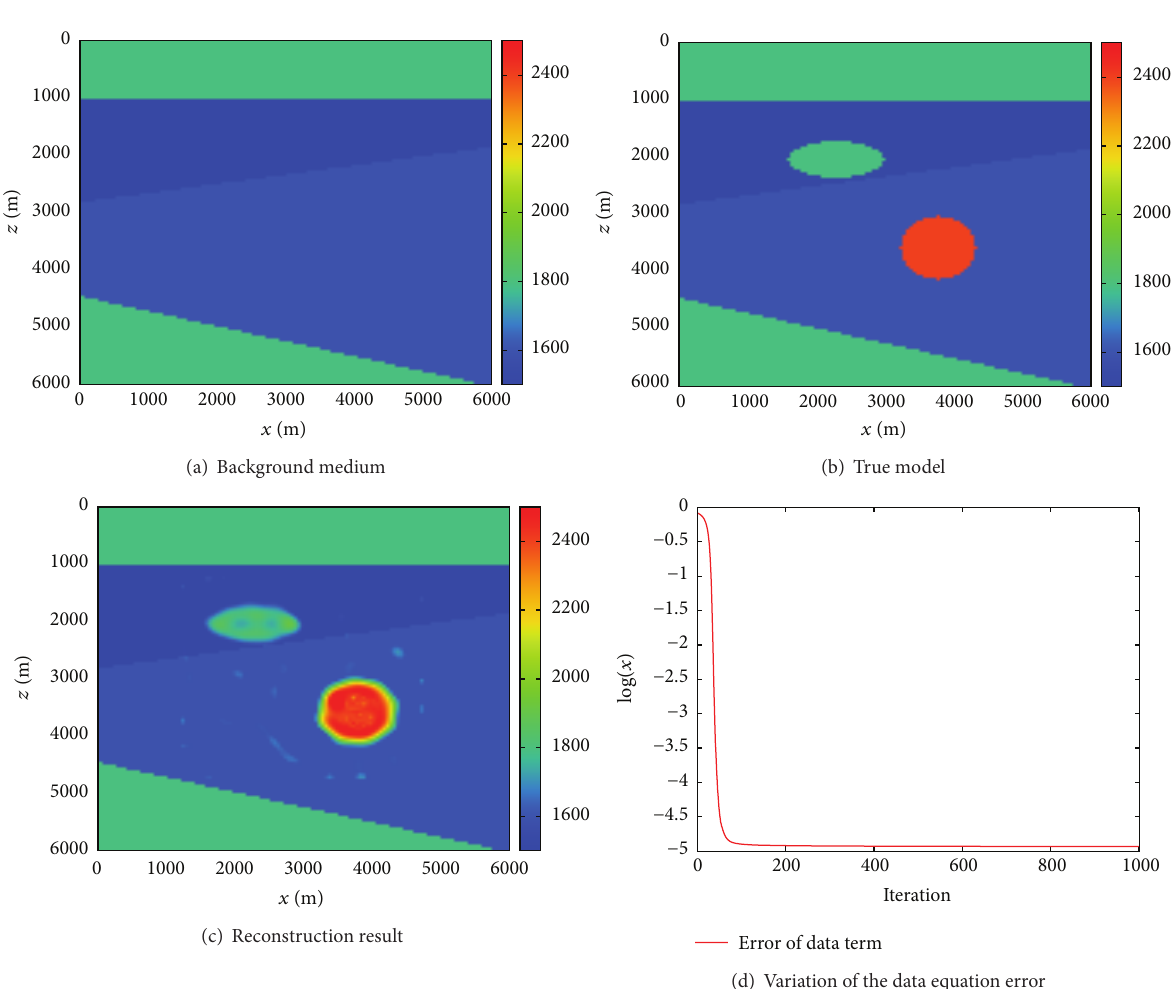
(d) Variation of the data equation error Figure 3: Applying the FD-CSI method to two abnormities inversion in an inhomogeneous background medium. (a) Background medium.